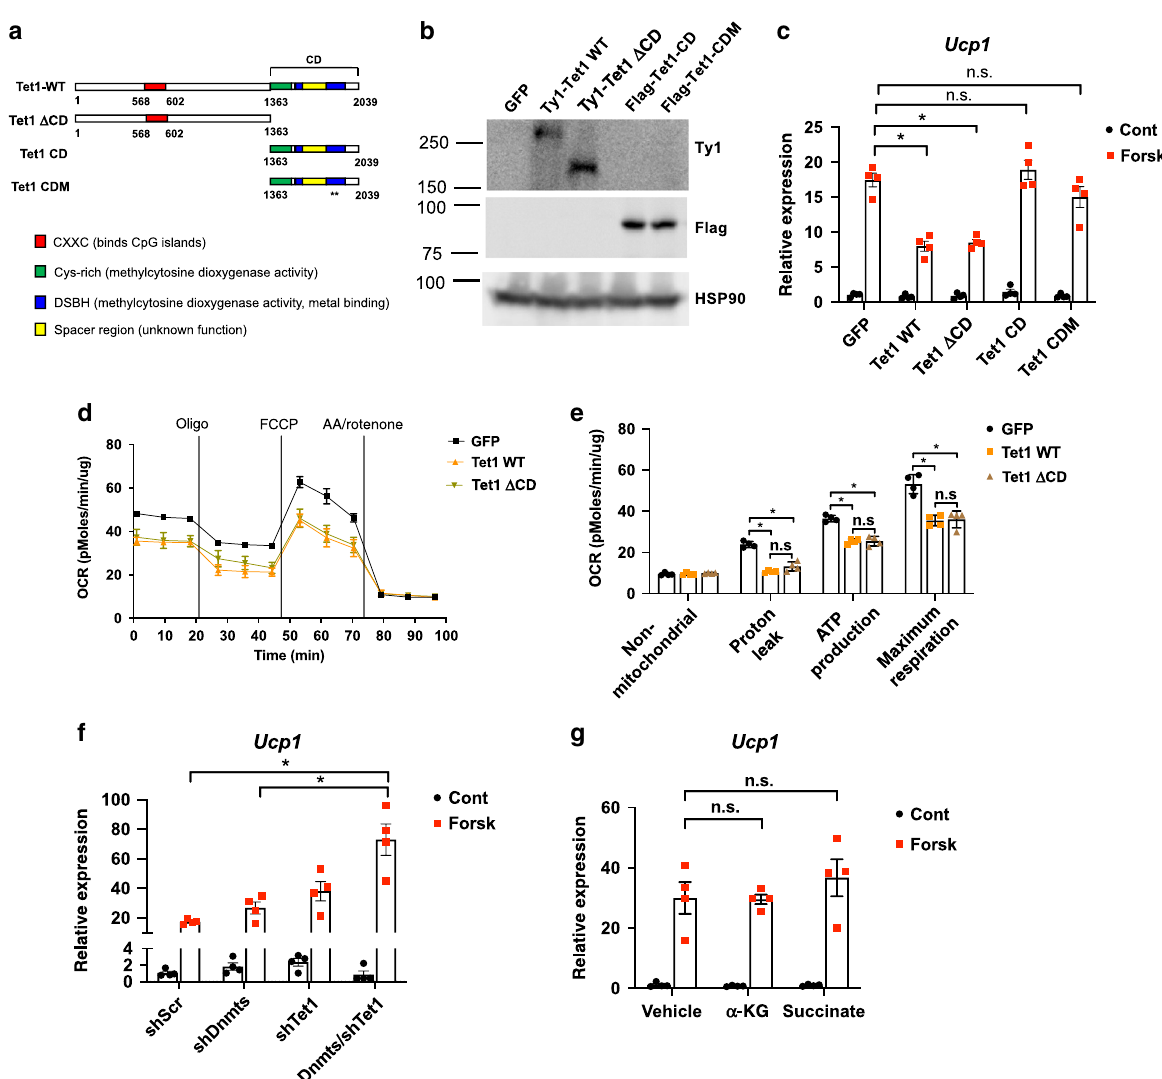
Fig. 6 TET1 suppresses the thermogenic gene program in a DNA demethylase – independent manner. a The protein map showing Tet1 wild-type and mutant alleles: the Tet1 wild-type (Tet1 WT) allele, a truncation mutant that lacks DNA demethylase activity (Tet1 Δ CD), a mutant that contains only DNA demethylase activity (Tet1 CD), and a catalytically inactive form (Tet1 CDM). b Mature beige adipocytes were transduced with lentiviral expression plasmids for the various Tet1 alleles from ( a ). c The basal- and forskolin-stimulated levels of Ucp1 were measured by qPCR from ( b ) ( n = 4 per group. Data are expressed as means ± SEM. *denotes p < 0.05, determined by two-tailed Student ’ s t test and one-way ANOVA followed by Bonferroni post-hoc testing). d , e Mitochondrial respiration is measured by Seahorse from beige adipocytes that overexpress Tet1 WT, Tet1 Δ CD, or GFP. ( n = 4 per group. Data are expressed as means ± SEM. *denotes p < 0.05, determined by two-tailed Student ’ s t test and two-way ANOVA followed by Bonferroni post-hoc testing). f Beige adipocytes were transduced with hairpins against Dnmt1 , 3a , and, 3b or control scramble RNA (shScr), and differentiated beige adipocytes were transduced with shTet1. The basal- and forskolin-stimulated levels of Ucp 1 were measured by qPCR ( n = 4 per group. Data are expressed as means ± SEM. *denotes p < 0.05, determined by two-tailed Student ’ s t test and two-way ANOVA followed by Bonferroni post-hoc testing). g Alpha-KG ( α -KG), diethyl-succinate (Succinate), or a vehicle was used to pre-treat mature beige adipocytes for 3 hr. The basal- and forskolin-stimulated levels of Ucp1 were measured by qPCR ( n = 4 per group. Data are expressed as means ± SEM. *denotes p < 0.05, determined by two-tailed Student ’ s t test and